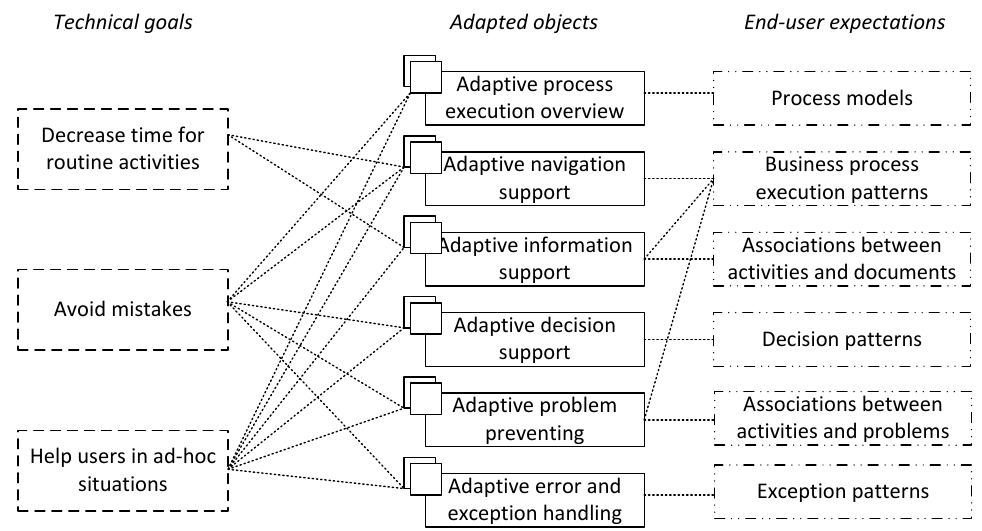
Figure 10. Relationships between UAEA technical goals, adapted objects and end-user expectations Table 2. Adapted objects